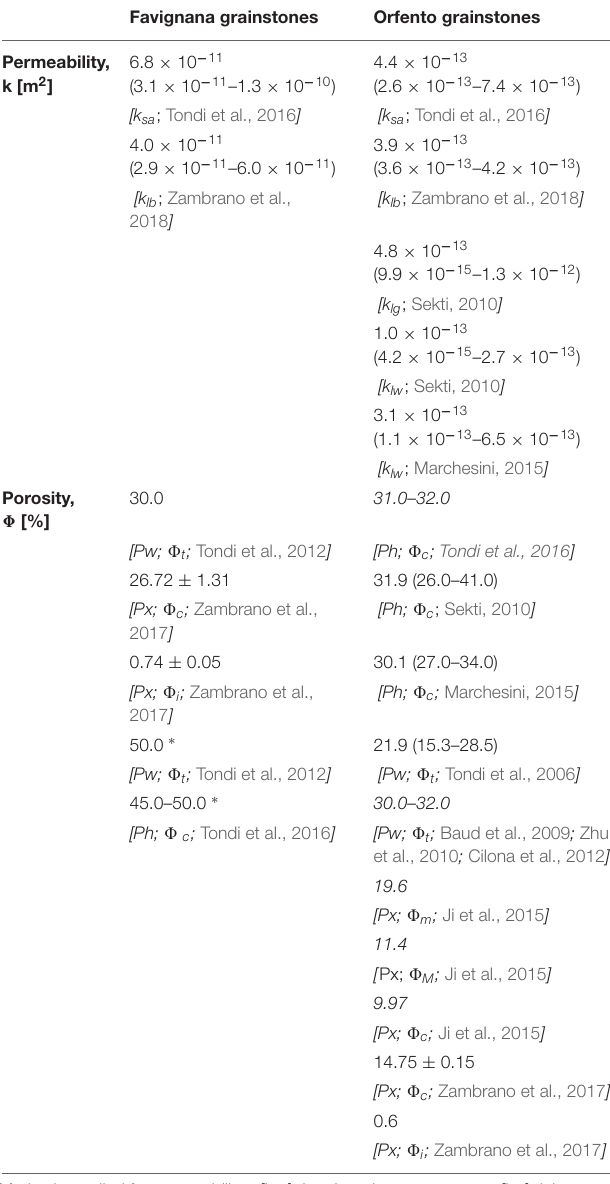
TABLE 2 | Porosity and permeability data for the studied